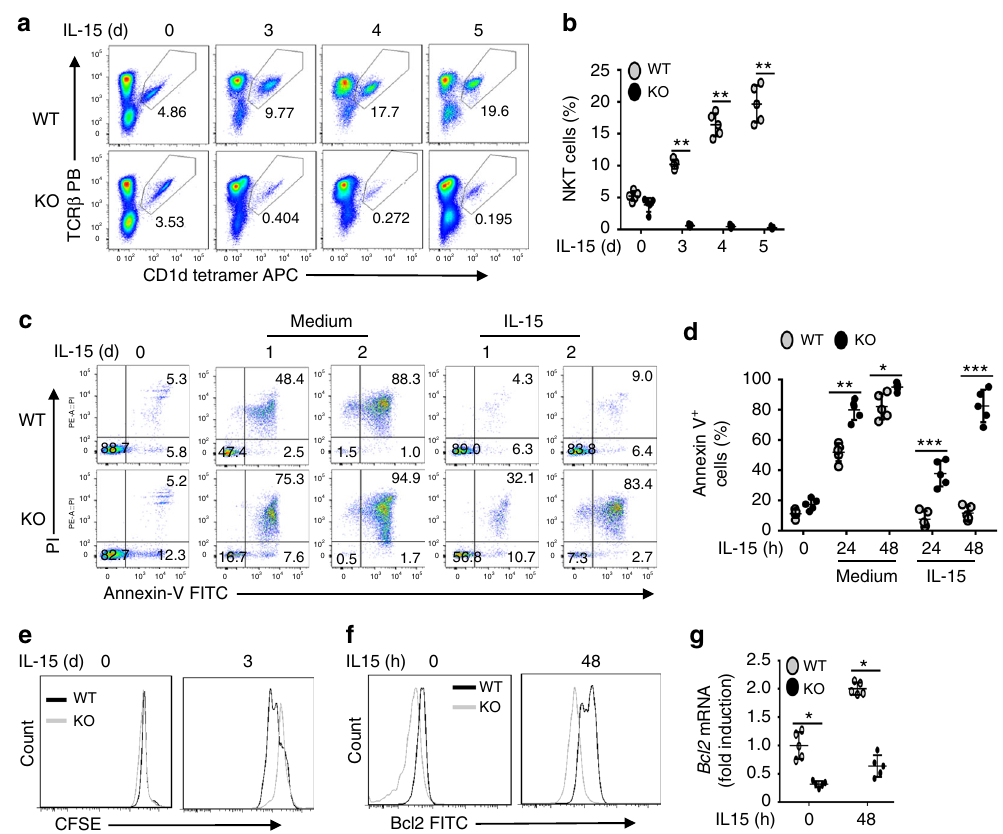
Fig. 4 Tbkbp1 mediates IL-15-stimulated NKT cell survival. a , b Flow cytometric analysis of NKT cell frequency in NKT-enriched WT and Tbkbp1 -KO thymocytes (CD8 + cells depleted by microbeads) after in vitro incubation with IL-15 for the indicated time periods. Data are presented as a representative plot ( a ) and summary graph ( b ). c , d Flow cytometry analysis of apoptotic cells (based on AnnexinV and PI staining) in enriched thymic NKT cells cultured for indicated time periods with IL-15 or medium control. Data are presented as a representative plot ( c ) and summary graph ( d ). e Proliferation assays (based on CFSE dilution) of WT or Tbkbp1 -KO thymic NKT cells labeled with CFSE and cultured for the indicated time with IL-15. f , g Flow cytometric analysis of intracellular Bcl-2 level ( f ) and qRT-PCR analysis of Bcl2 mRNA ( g ) in WT or Tbkbp1 -KO thymic NKT cells, either freshly isolated or cultured with IL-15 for 48 h, presented as a representative plot (left) and summary graph (right). All summary graphs are presented as mean ± s.d. values based on 5 WT and 5 Tbkbp1 -KO mice. The similar data were obtained from at least three independent experiments. * P < 0.05; ** P < 0.01; *** P < 0.001. Mann – Whitney test ( b ), Student ’ s t -test ( d , g